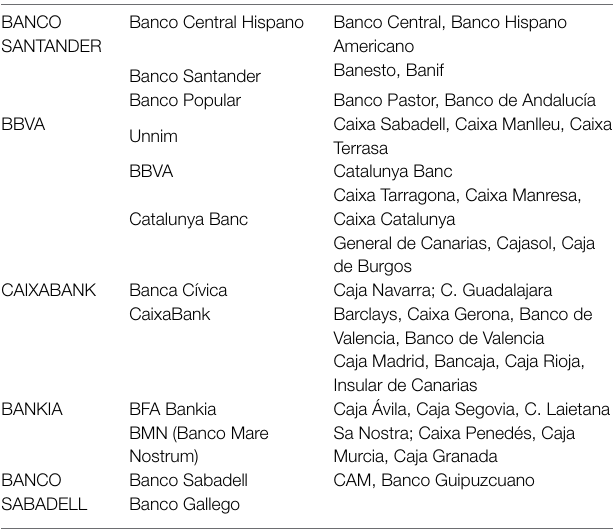
TABLE 1 | Mergers in the banking system in Spain as of